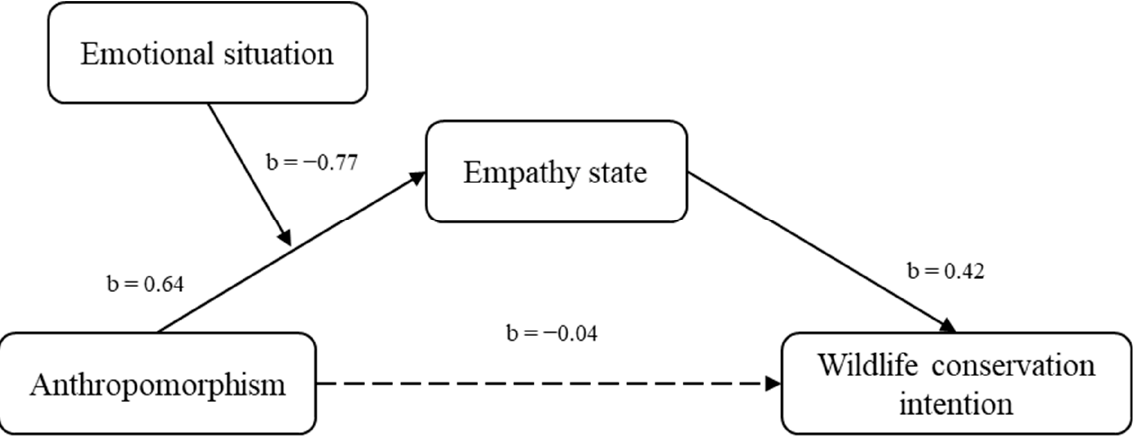
Figure 1. The interaction effect of emotional state on anthropomorphism and wildlife conservation intention (Notes: The dotted line indicates that the path coefficient is not significant).